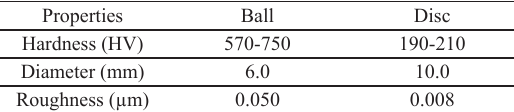
Table 3. Characteristics of the tribological pair 9 Properties